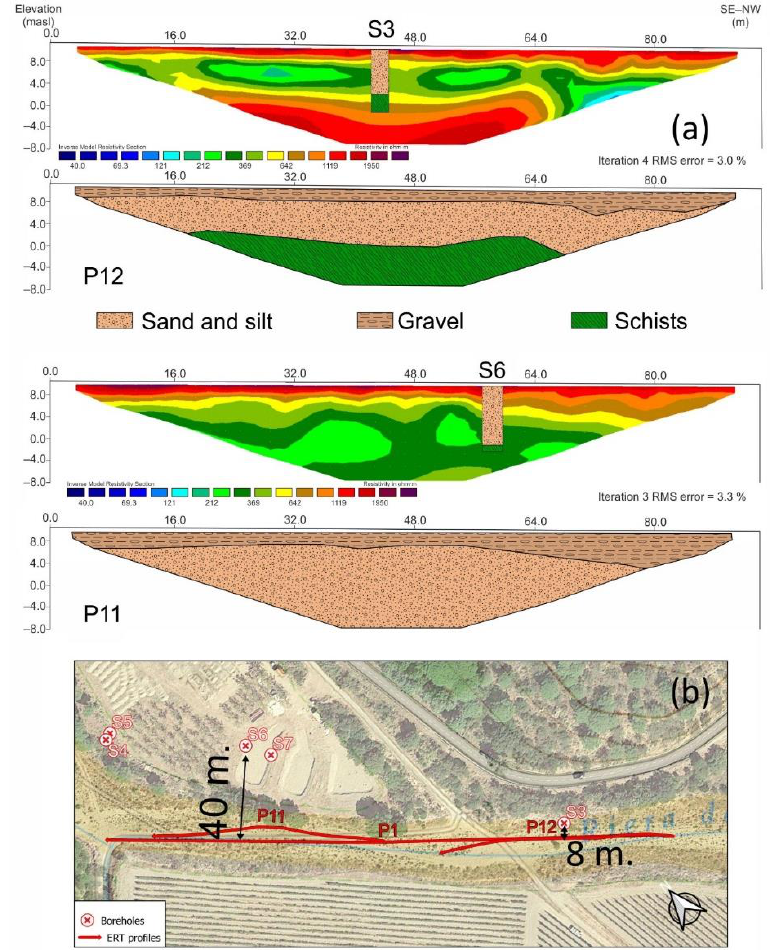
Figure 8. ( a ) P11 and P12 inverted resistivity cross-section and its lithological interpretation; ( b ) location sketch of boreholes S3 and S8 and ERT cross-sections P11 and P12 (Port de la Selva).